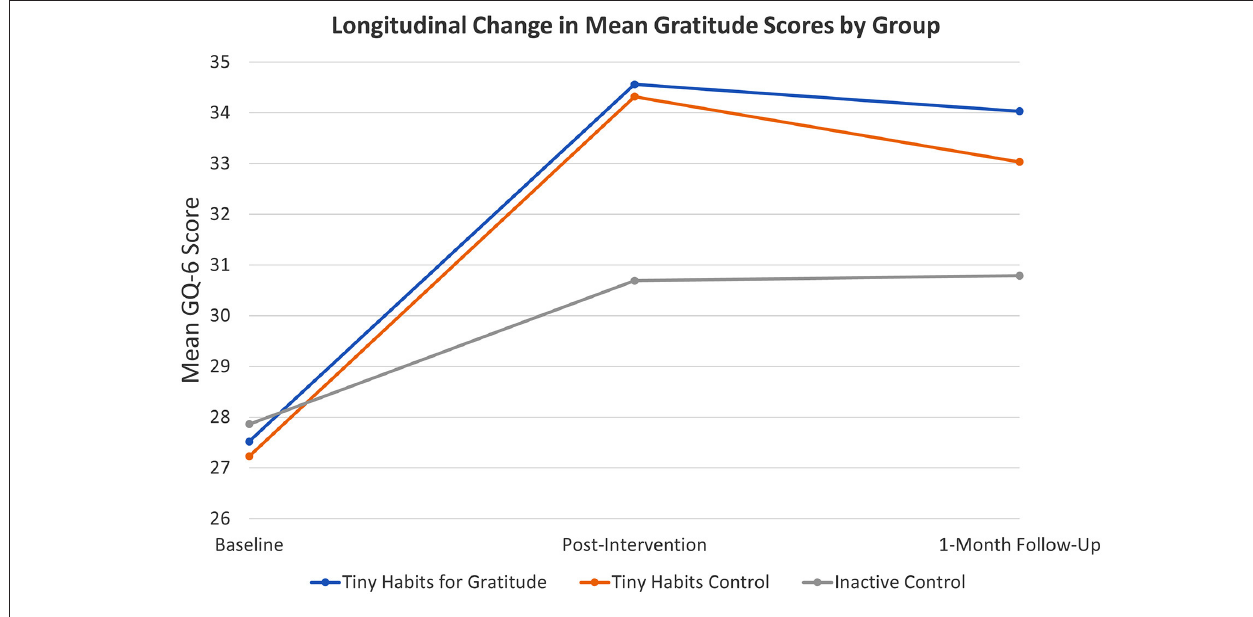
FIGURE 2 | Longitudinal change in mean gratitude scores by